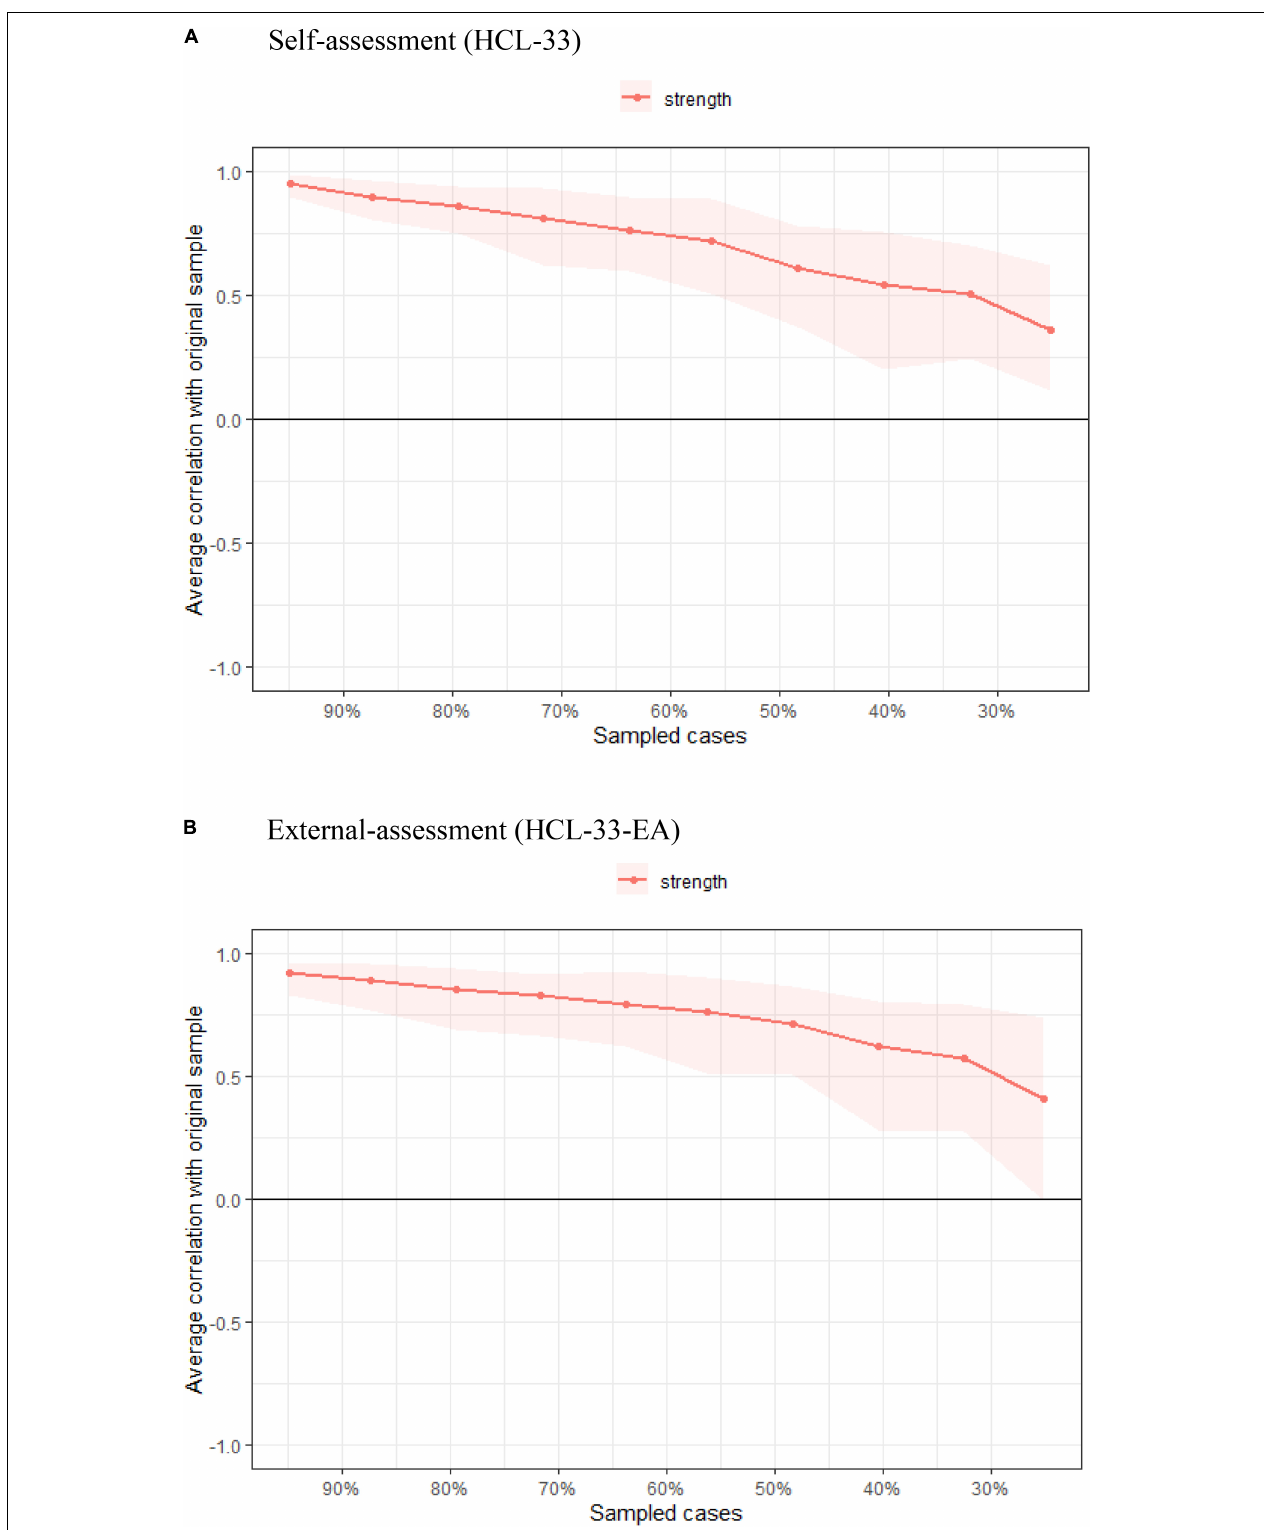
FIGURE 3 | Comparison of stability of centrality indices between HCL-33 (A) and HCL-33-EA (B) . The x -axis represents the percentage of cases in the original sample used at each step. The y -axis represents the average of correlations between the centrality indices in the original network and the centrality indices in the networks that were re-estimated after dropping increasing percentages of cases. Color areas indicate 95% confidential intervals.